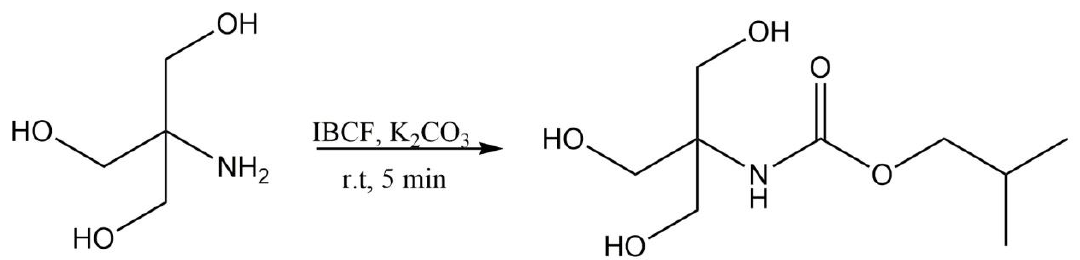
Figure 1. Scheme of the reaction of Tris(hydroxymethyl)aminomethane (TRIS) with IBCF.